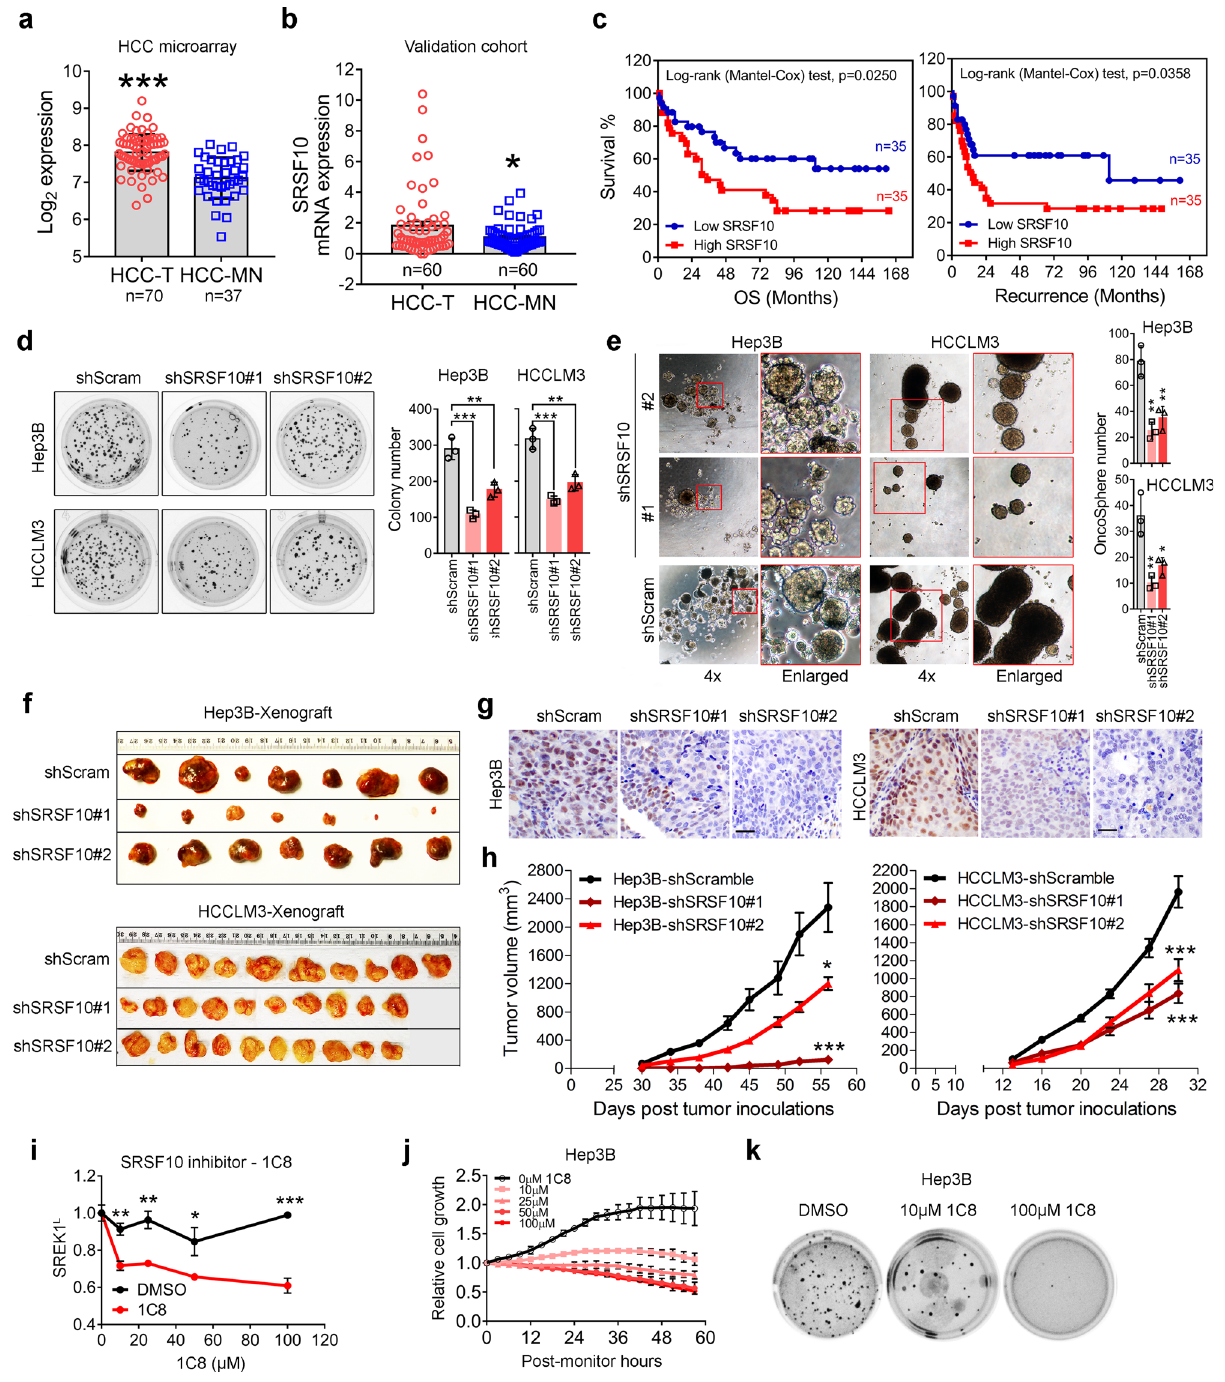
Fig. 6 SRSF10 is associated with poor prognosis of HCC patients and acts as an oncogenic driver in HCC. Expression of SRSF10 in HCC-T and HCC-MN using a a microarray database generated in our laboratory 35 or b PCR assay on a HCC cohort composed by 60 pairs HCC tissues (two-tailed, paired t test). c Comparison of OS and recurrence between HCC patients with high or low SRSF10 expression analyzed by our microarray database 25, 35 . d Anchorage- independent soft agar colony formation assay ( n = 3) or e the oncosphere formation assays of the effect of SRSF10 or scramble control stable knockdown in HCCLM3 and Hep3B cells ( n = 3). The representative tumor pictures ( f ), immunohistochemical staining (scale bar = 100 μ m) ( g ), and tumor volume ( h ) of the mouse subcutaneous tumorigenic assay of the effect of SRSF10 or scramble control stable knockdown on the tumorigenesis of the Hep3B ( n = 7) or HCCLM3 ( n = 10) cells. Mean ± SEM; * p < 0.05; *** p < 0.001. i The inhibition of the 1C8, an SRSF10 inhibitor, on SREK1 L expression in Hep3B cells. j The cell growth and k the anchorage-independent soft agar colony formation assays of 1C8 on the inhibition of Hep3B cells ( n = 3). Mean ± SD, * p < 0.05; ** p < 0.01; *** p < 0.001, two-tailed, unpaired t test is used for ( a , d , e , h , i ) for; * p < 0.05; ** p < 0.01; *** p < 0.001. Source data are provided as a Source Data fi